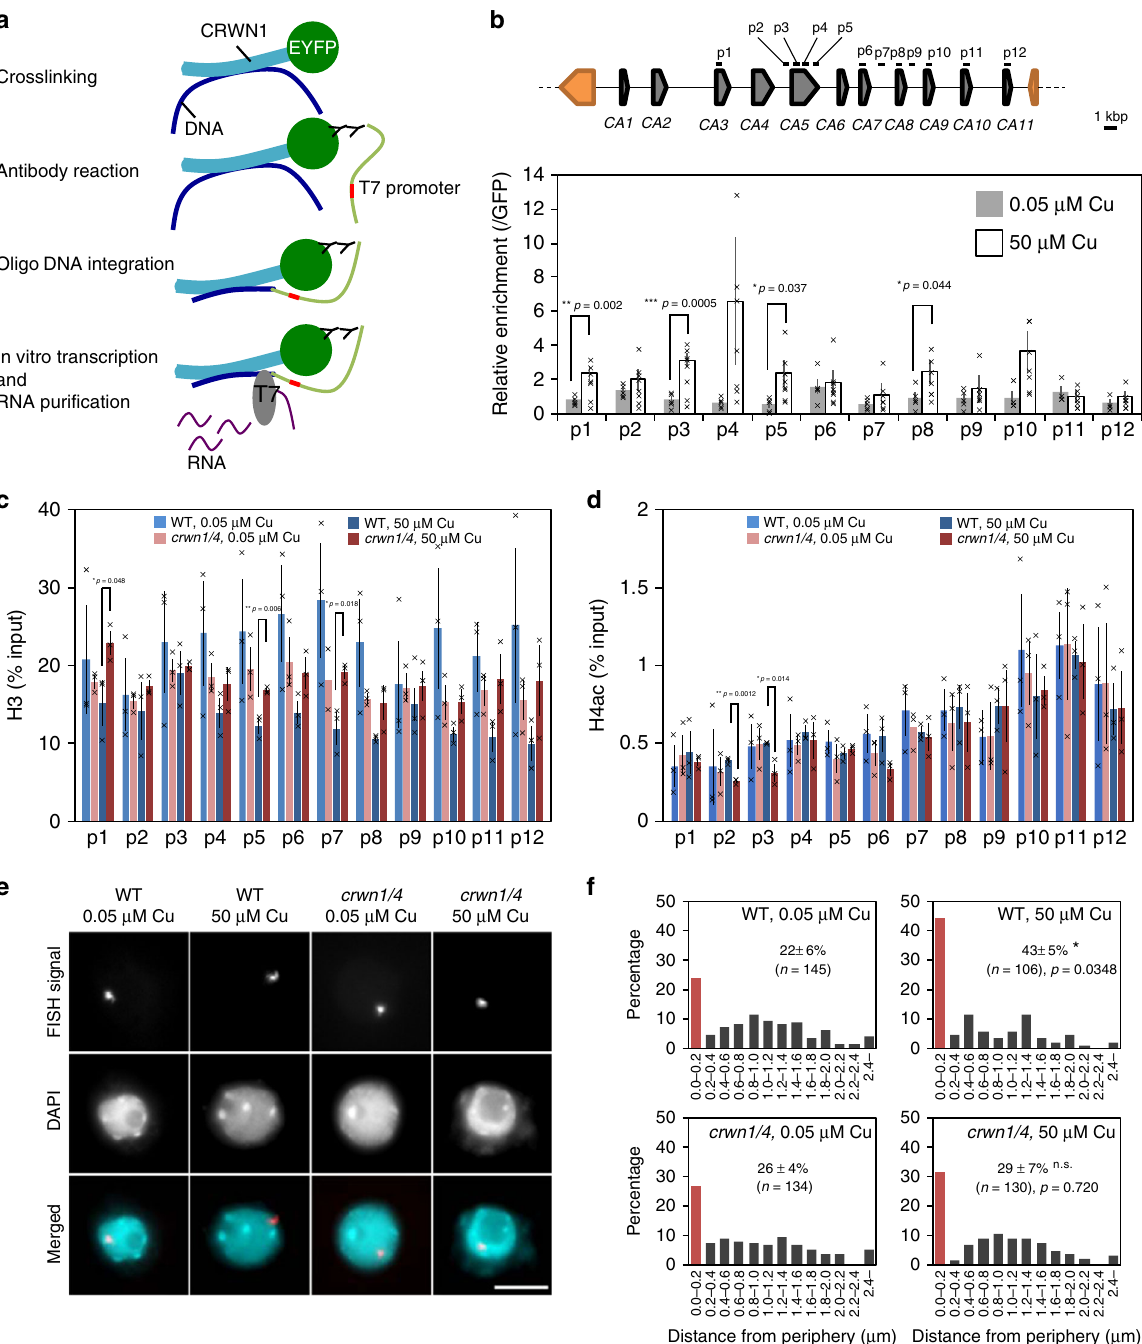
Fig. 5 CRWNs regulate the position of the CA gene locus depending on copper concentration. a Outline of chromatin integration labeling (ChIL) method. b ChIL-qPCR analyses using 12 primer pairs described as p1 to p12. Top image indicates the position of primer pairs at the CA gene locus. Data were normalized to ChILed DNA levels in GFP control and are expressed as mean ± SEM. Signi fi cance was determined using unpaired two-sided t -test ( n ≥ 4 individual experiments). Each data point represents a cross mark. c , d ChIP assay for histone H3 ( c ) and H4 acetylation ( d ) in the CA gene locus under normal and excess copper conditions. Data are expressed as mean ± SEM. Signi fi cance was determined using unpaired two-sided t -test ( n = 3 individual experiments). Each data point represents a cross mark. e Visualization of the CA gene locus in the nucleus by padlock FISH. In the merged panel, FISH signals are red and DAPI signals are cyan. Scale bar = 5 µ m. Data are from single representative experiments that were reproduced three times. f The distance between the CA gene locus and the nuclear edge was measured. The red bars in the histogram represent the nuclear periphery including the region 0.0 to 0.2 μ m from the nuclear edge. The average percentage of the CA gene locus within the nuclear periphery with SEM from three independent replicates is shown. “ n ” represents the total number of FISH signals analyzed from all replicates. The CA gene locus distribution data under normal conditions were compared with those under excess copper conditions in WT and crwn1crwn4 . Signi fi cance was determined using unpaired two-sided t